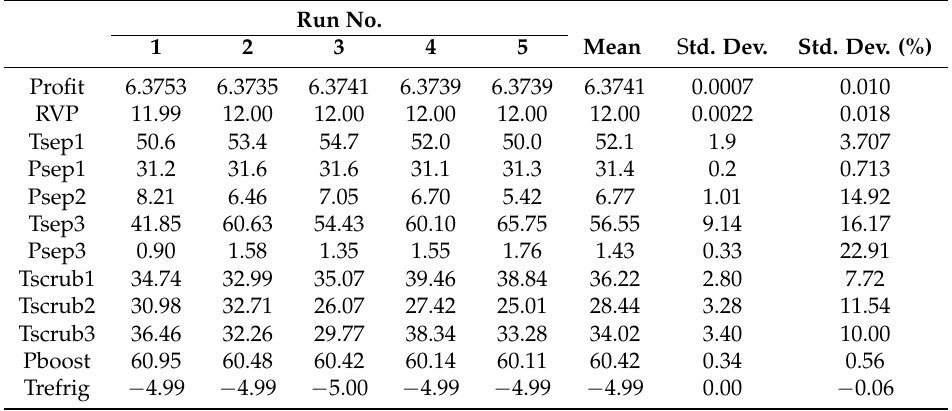
Table 6. Profitmaximum obtained by optimization of the black-box model (process simulation) directly using the NSGA-II